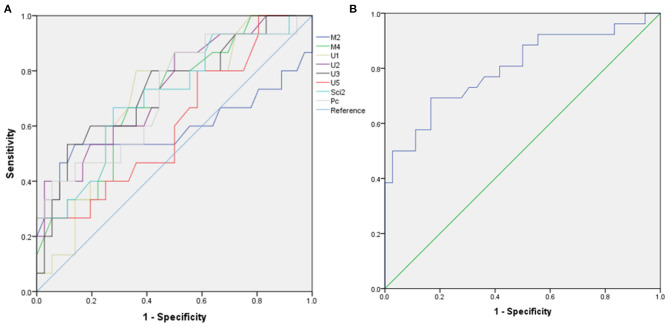
Receiver operating characteristic (ROC) curve for differentiating transthyretin familial amyloid polyneuropathy (TTR-FAP) from chronic inflammatory demyelinating polyneuropathy (CIDP). (A) Mean CSAs at M2, M4, U1-3, U5, Sci2, Pc sites between the two groups. (B) CSA-variability of median nerves between the two groups.